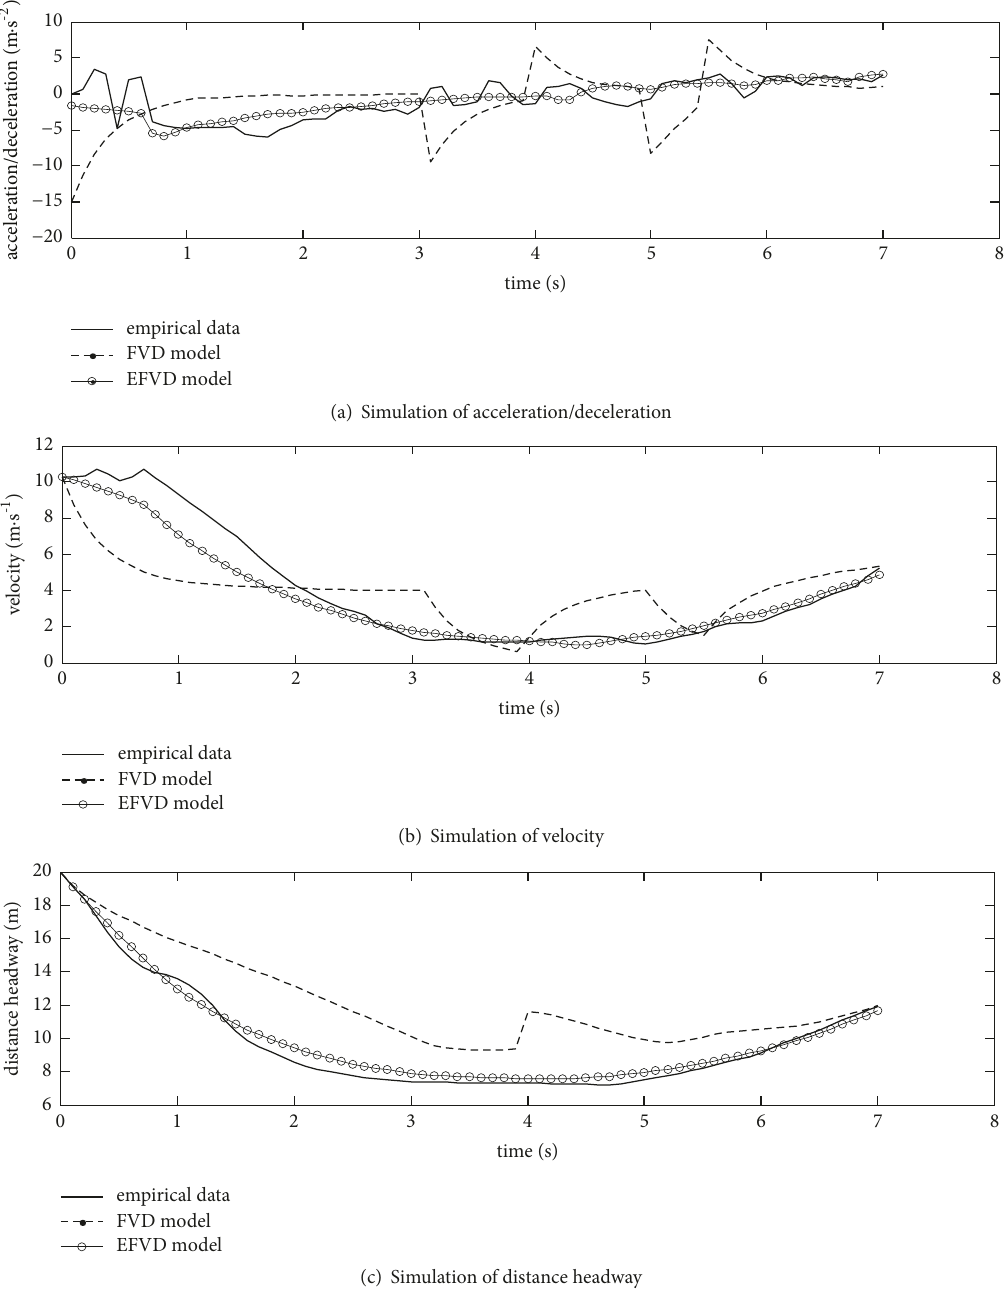
Figure 11: Simulation comparison of car-following Process